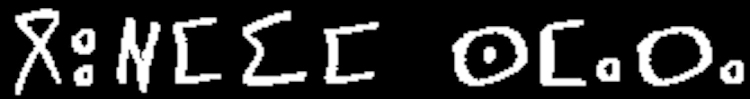
The original image.